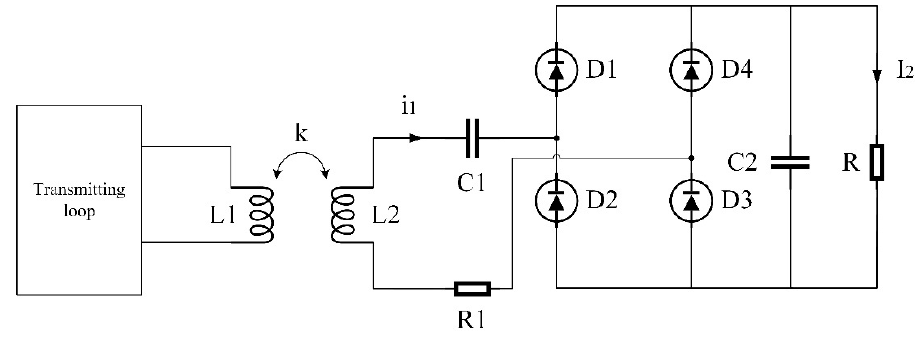
Figure 3. Schematic diagram of the full-bridge rectifier.